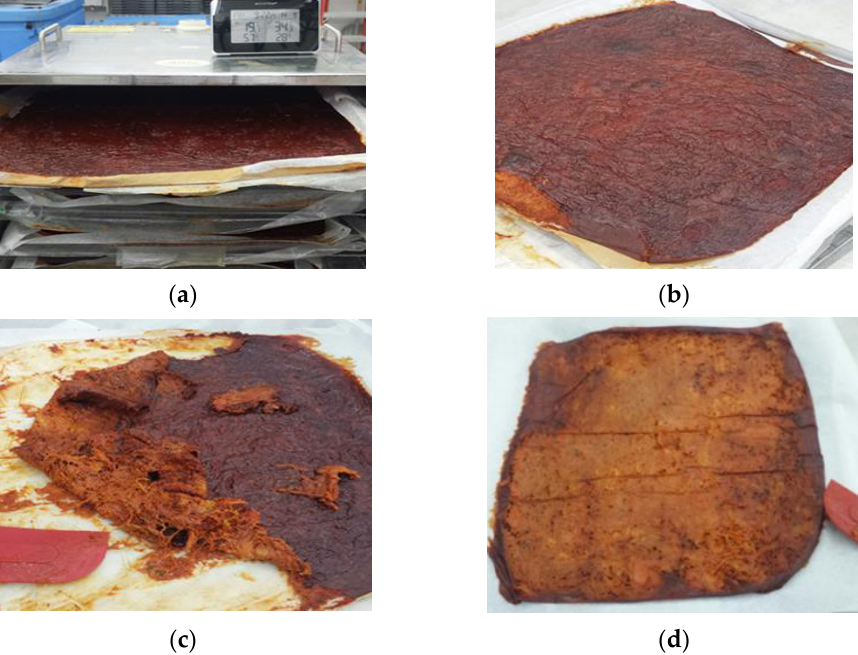
Figure 2. ( a ) Air drying of SCV at 34 ◦ C; ( b ) partially dried SCV after 24 h at 34 ◦ C; ( c ) flipping over the partially dried material; ( d ) SCV after flipped over, ready for 2nd round of